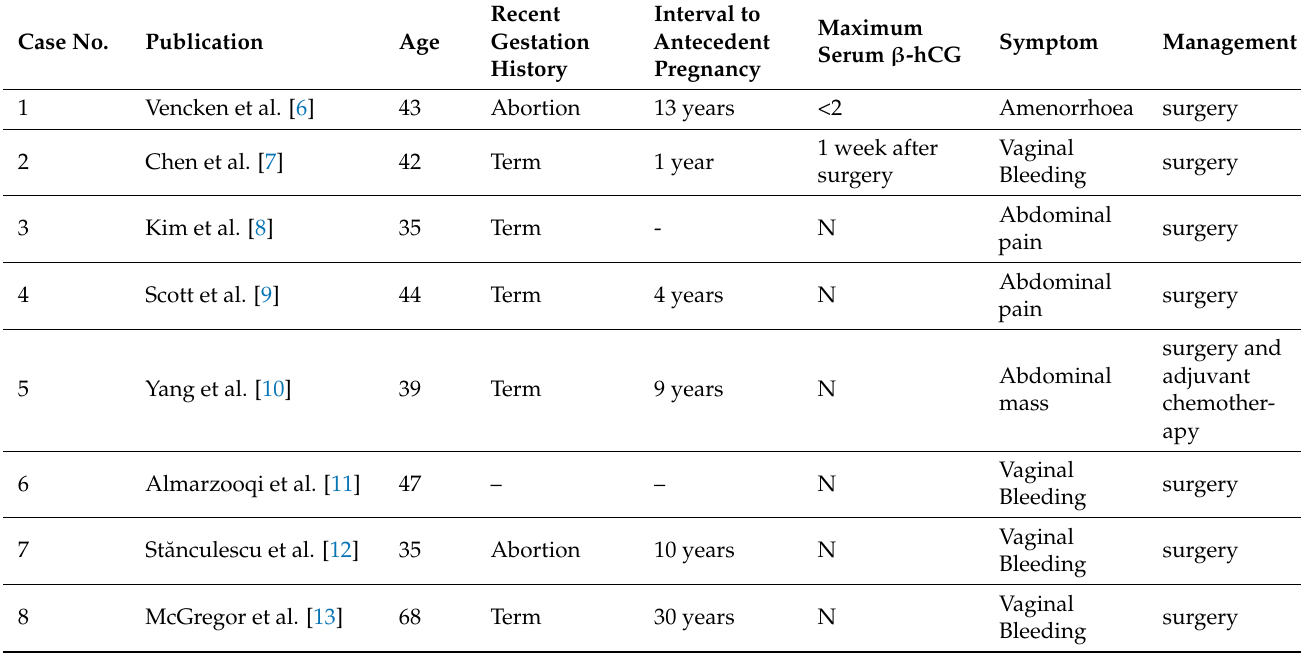
Table 1. Clinical data and management for cases in the literature with ETT and normal β -hCG levels.